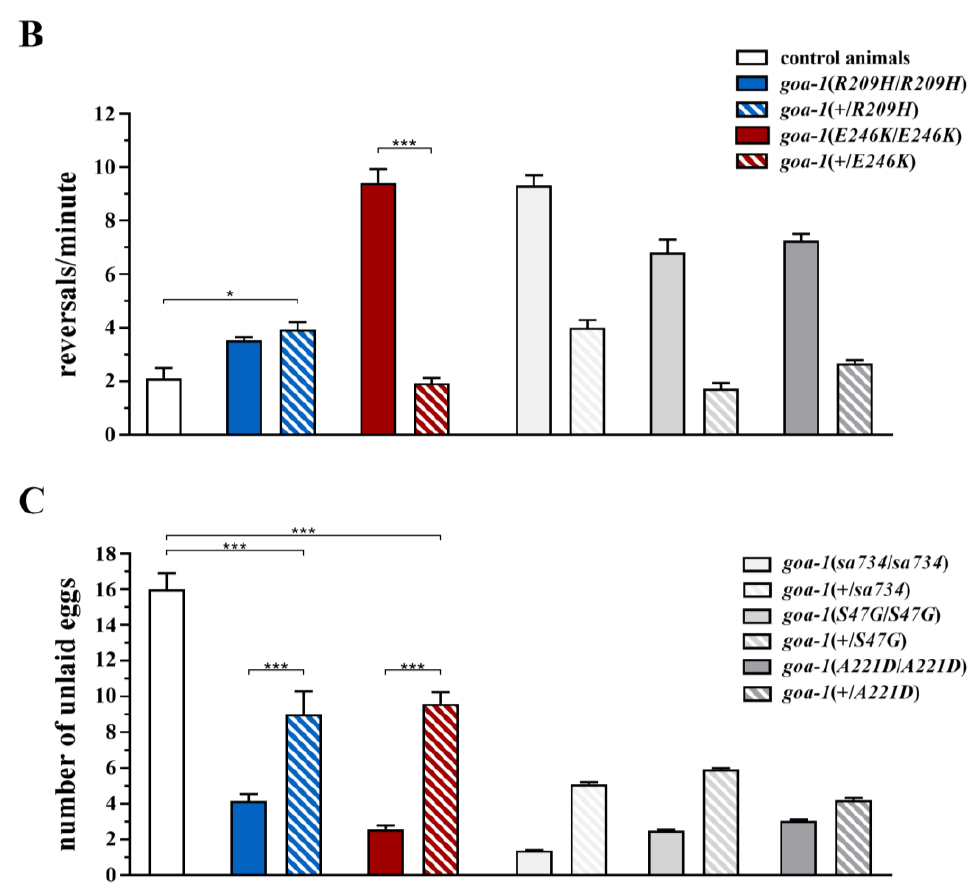
Figure 4. The monoallelic goa-1 (+/R209H) allele displays a cell-specific dominant-negative behavior in C. elegans neurons. The sensitivity to aldicarb ( A ), the reversal rate ( B ), and the number of retained eggs ( C ) were assessed in worms carrying the goa-1 mutations in a heterozygous state. goa-1 (+/R209H) animals displayed hypersensitivity to aldicarb-induced paralysis ( p < 0.005; log-rank test) and an increased reversal rate (* p < 0.05 and *** p < 0.0001; one-way ANOVA with Bonferroni correction), whose severity was undistinguishable compared with that of animals carrying the mutation in a homozygous state. These data suggest a DN behavior of the R209H variant in ventral cord motor neurons and possibly in AVA neurons, but not in HSN motor neurons (egg laying activity was not significantly affected in heterozygous worms) ( C ). No relevant phenotypes were observed in the hT2-balanced goa-1 (+/E246K) mutants (PHX6121 strain). Twenty animals for each genotype were tested. Data represent means ± SEM of multiple experiments that were carried out using three unrelated clones generated following genetic crosses to control animals. Data collected in our previous study [18] are included in panels B and C for comparison (gray bars). sa734 is a null allele of goa-1 [30,32]. The behavior of goa-1 (+/ sa734 ), goa-1 (+/S47G), and goa-1 (+/A221D) heterozygous animals is also shown (panels B , C ).